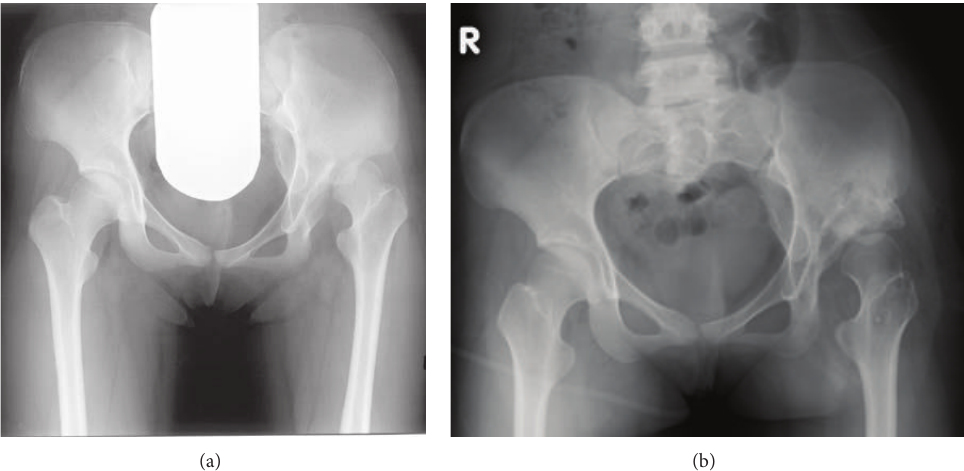
Figure 4: A 13-year-female with left hip subluxation associated with acetabular dysplasia and partial sacral agenesis. (a) A preoperative AP radiograph of the pelvis. (b) An AP radiograph obtained one year after the operation demonstrated partial left sacral agenesis with a rudimentary sacrum had fused with the ilia below the sacroiliac joint.